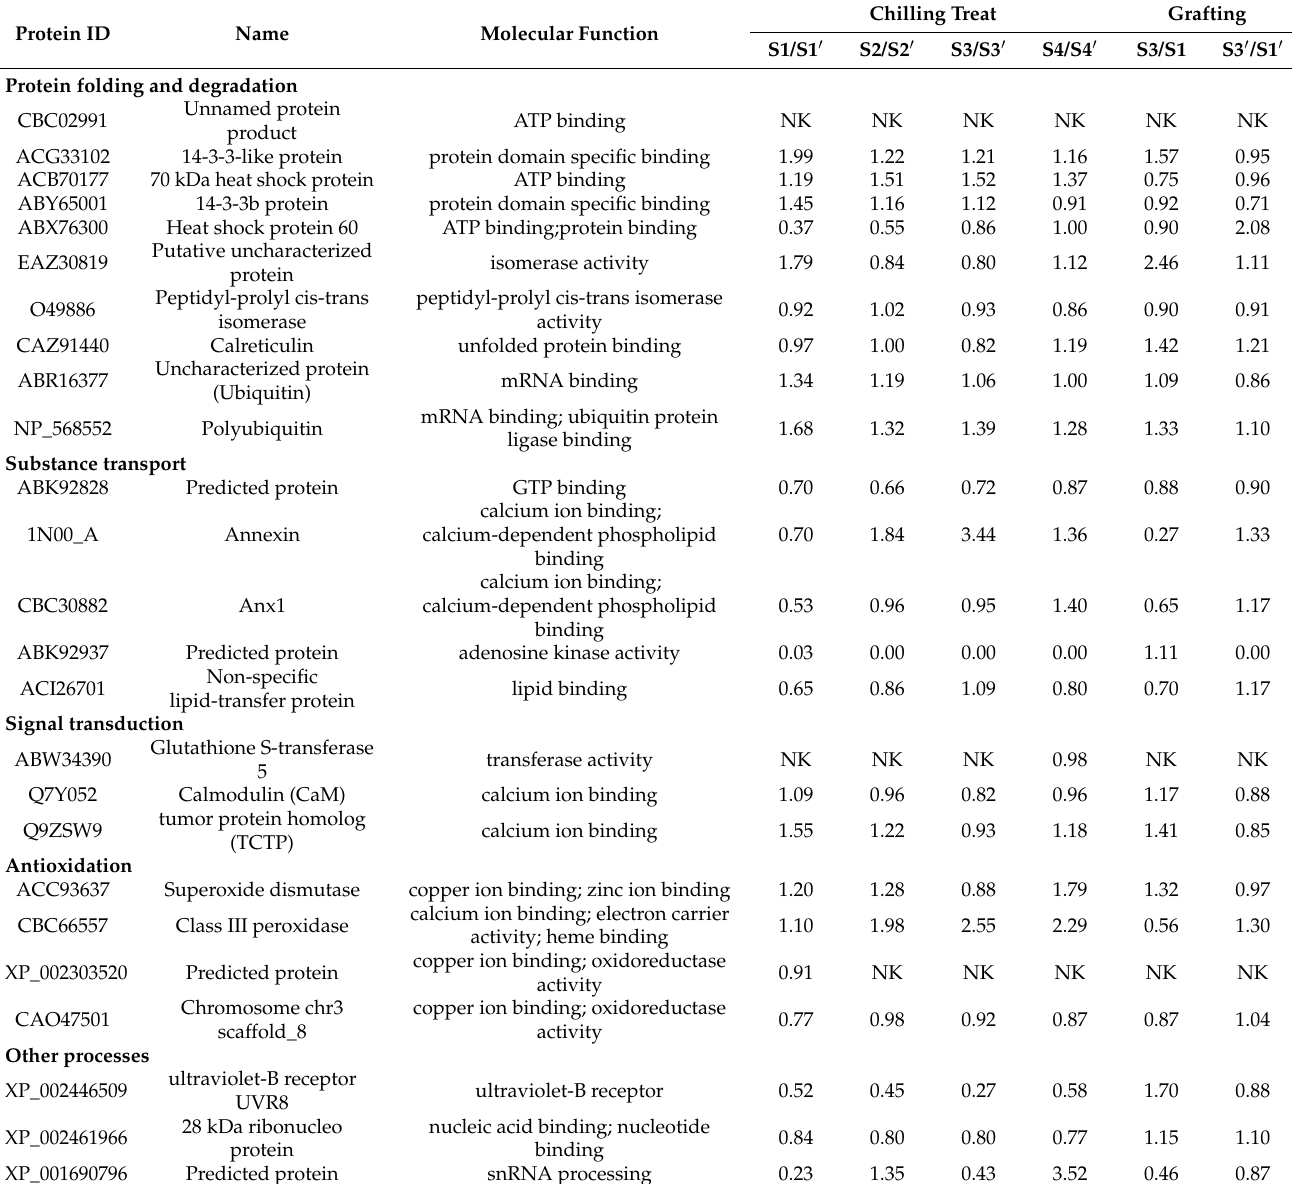
Table 10. Differential proteins related to folding and degradation, transport, signal transduction, antioxidation, and other processes in the cotton stem bark induced by chilling stress and